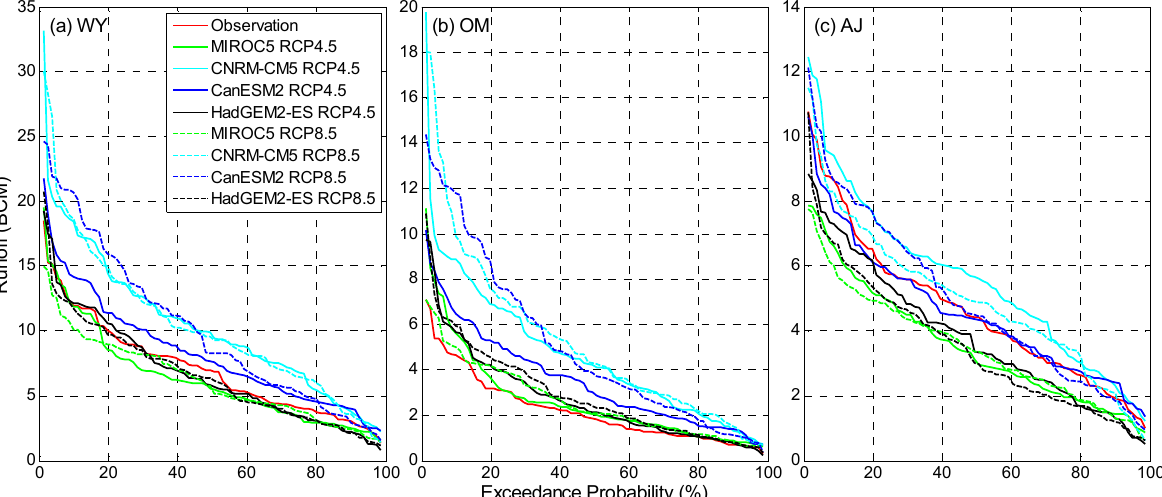
Figure 3. Exceedance probability curves for observed and projected ( a ) water year; ( b ) October–March; and, ( c ) April–July total SJQ4 runoff volume. Note scale difference in Y -axis across three panels.